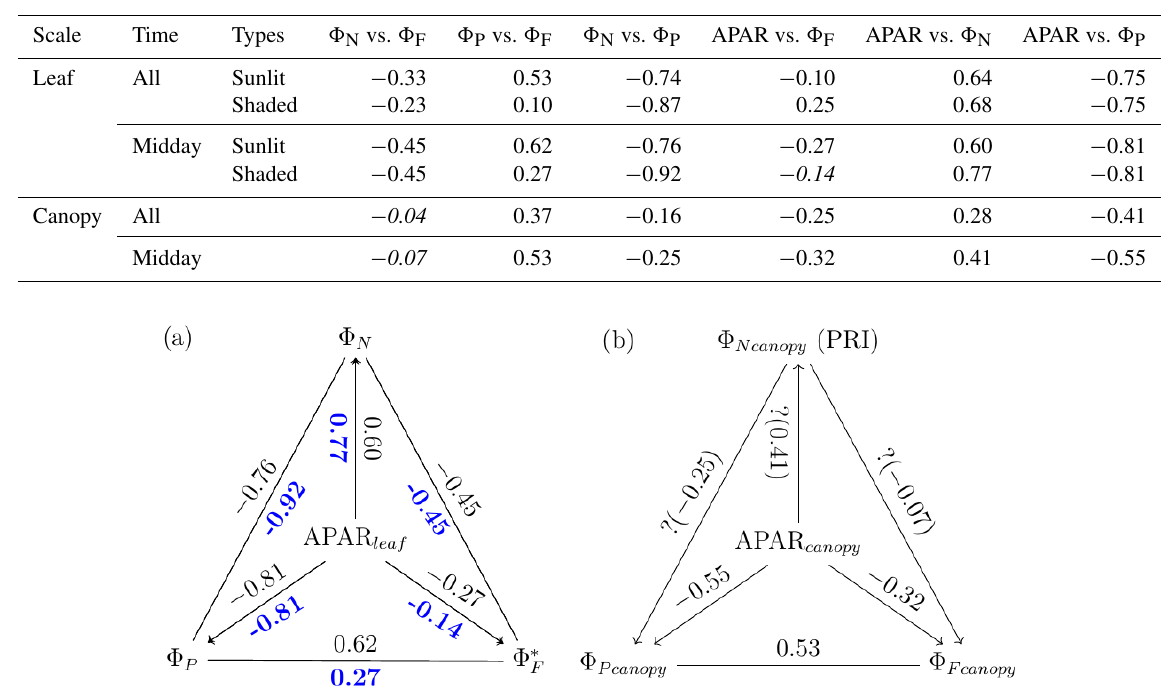
Figure 12. Reproduction of Fig. 11 with only midday measurements (11:00–14:00LT). Data correspond to subsamples previously shown in Figs. 3e, 6c and